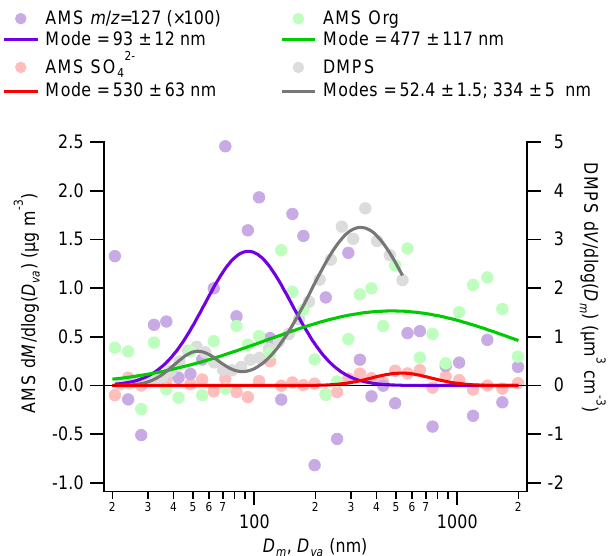
Figure 5. Size-resolved data from the DMPS and AMS, against electrical mobility and vacuum aerodynamic diameters respec- tively, during the period of highest iodine loading (26 July, 22:50– 23:45UTC) with lognormal nonlinear least squares fits and asso- ciated standard errors, comparing DMPS volume with AMS mass at m/z = 127, corresponding to I + , and sulfate and organic mat- ter. The low signal-to-noise ratios of the AMS data are due to the low concentrations and short averaging time. Note that the widths of the AMS distributions should not be directly compared against the DMPS, as the AMS distributions are subject to broadening in- troduced by the chopper wheel and variations in particle